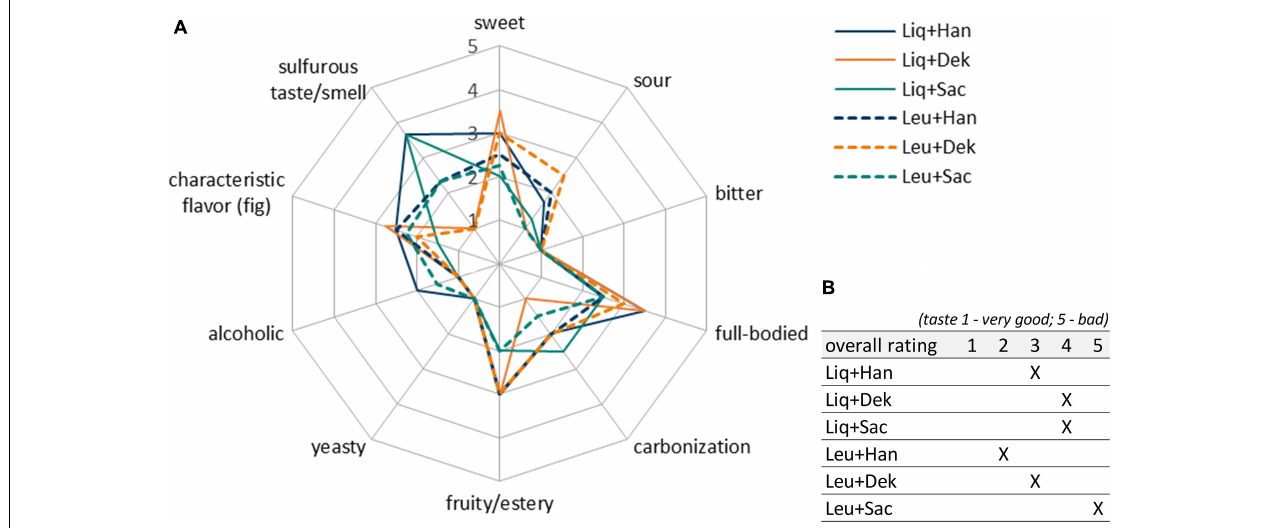
FIGURE 4 | Sensory properties of products fermented with different LAB–yeast combinations after 7 days of fermentation. Shown are the mean data of two samples produced in biological duplicates. The rating scale of the descriptive analysis (A) ranges from 1 (imperceptible) to 5 (very pronounced). The overall rating of the taste (B) ranges from 1 (very good) to 5 (bad taste). LAB, lactic acid bacteria.